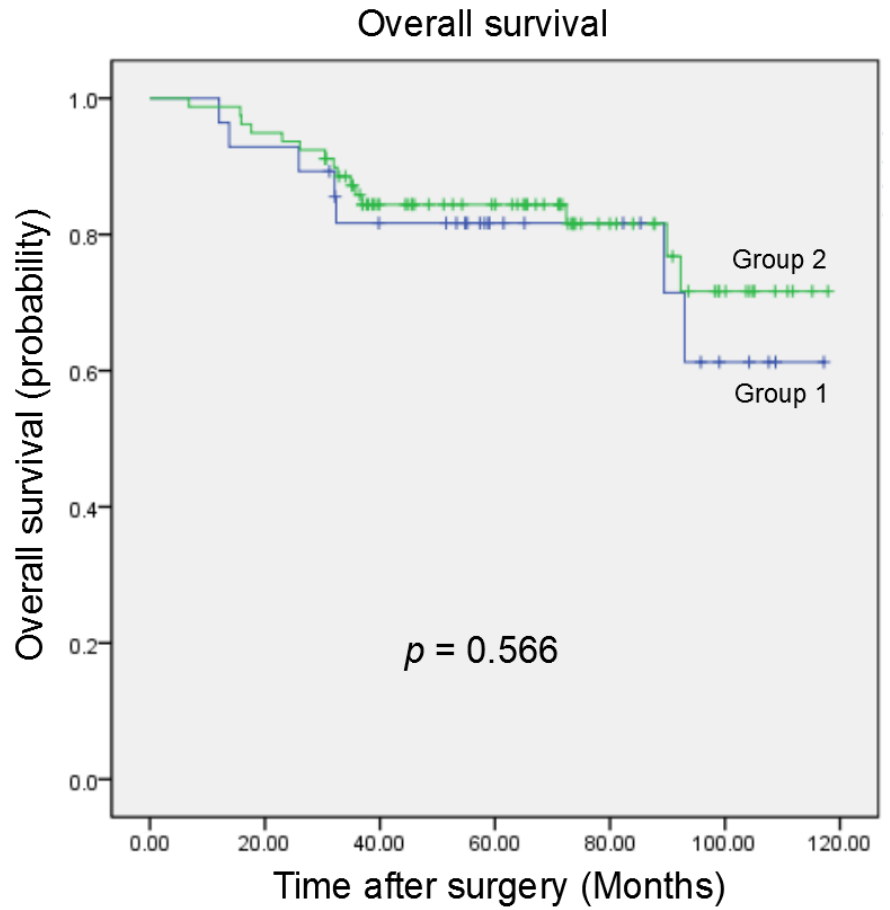
Figure 6. Survival outcomes: The Kaplan–Meier estimation showed no statistical difference in the OS (overall survival) rate between the lobe-specific lymph node dissection (L-SND) and systematic lymph node dissection (SND) groups.